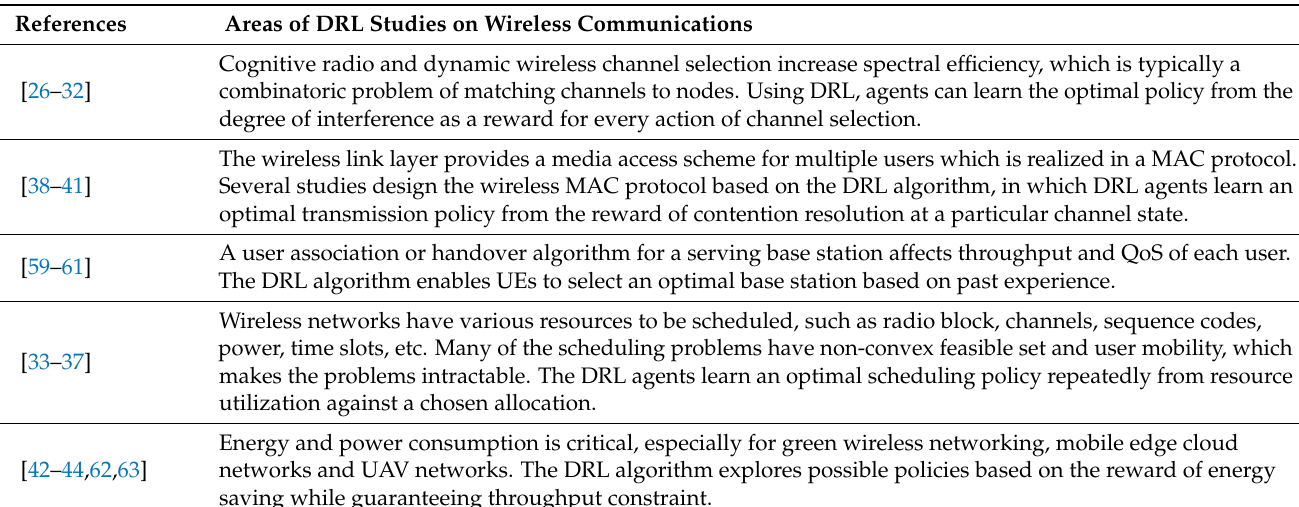
Table 1. DRL-empowered wireless communication and networking